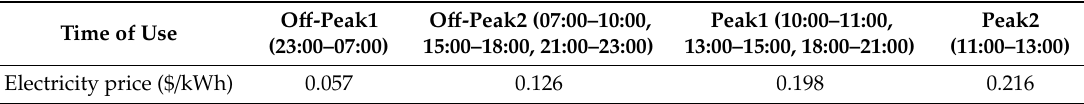
Table 5. Electricity Prices.